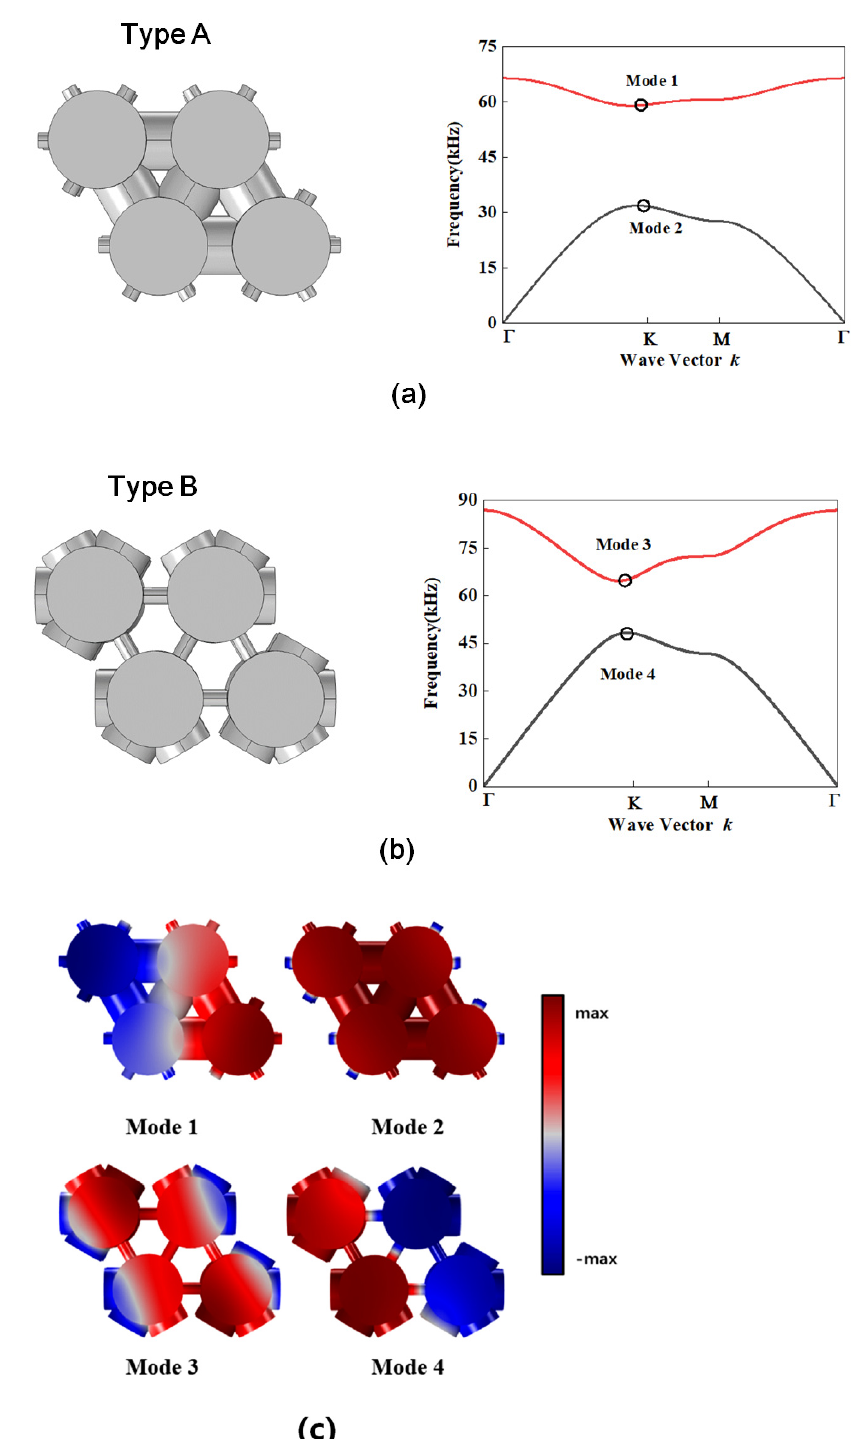
Figure 3. ( a ) The unit cell of type A and the according valley modes; ( b ) The unit cell of type B and the according valley modes; ( c ) Displacement field distributions of the valley modes.